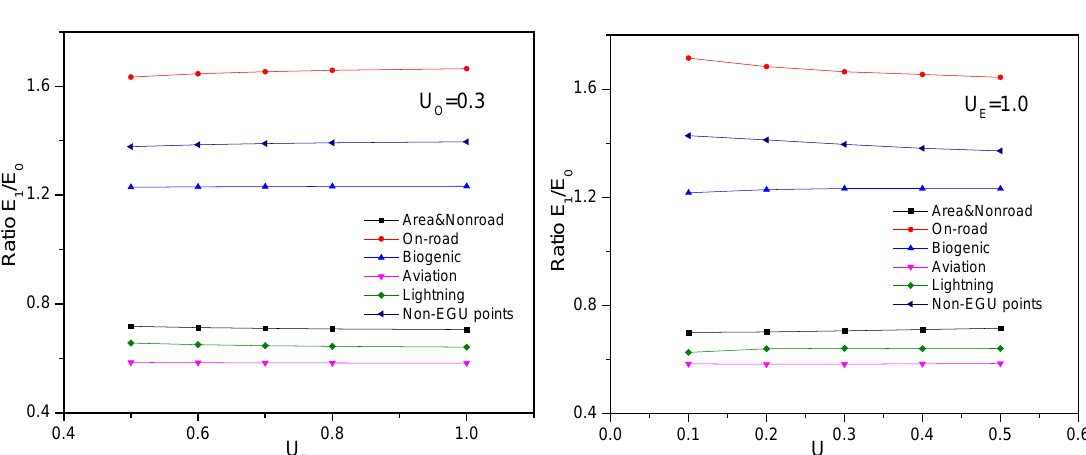
Figure 6. Pseudodata analysis for the sector-based DKF inversion (top), and its sensitivities to varied uncertainties in emissions (U E ) (bottom left) with 30% uncertainty in observation (U O ) and in observations (bottom right) with 100% uncertainty in emissions. Table 5. Evaluation of CAMx-modeled NO 2 using P-3 aircraft-measured NO 2 and NO y . Statistical NO ∗ 2 NO ∗ y parameters Priori Posteriori: region- Posteriori: sector- Posteriori: sector- Priori Posteriori: region- Posteriori: sector- Posteriori: sector- based inversion based inversion I based inversion II based